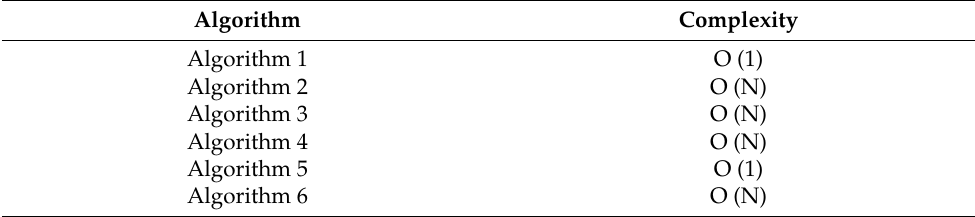
Table 11. Algorithm Complexity.